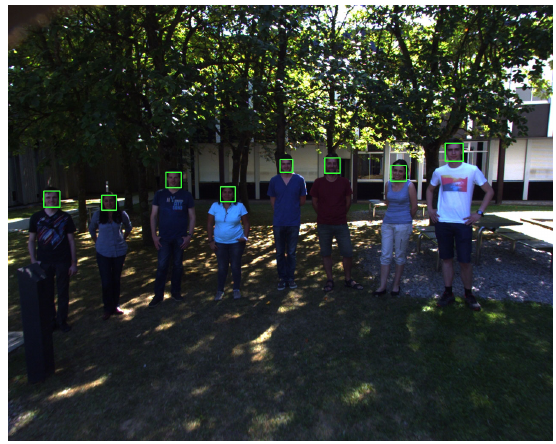
Figure 13. Shadow example: The detection is stable even during faster movement of the drone.